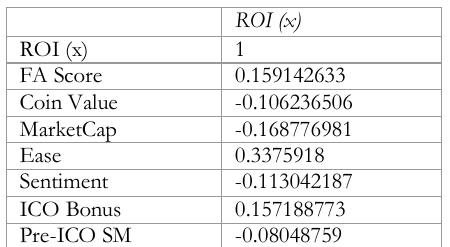
Table 1. Pearson’s Correlation